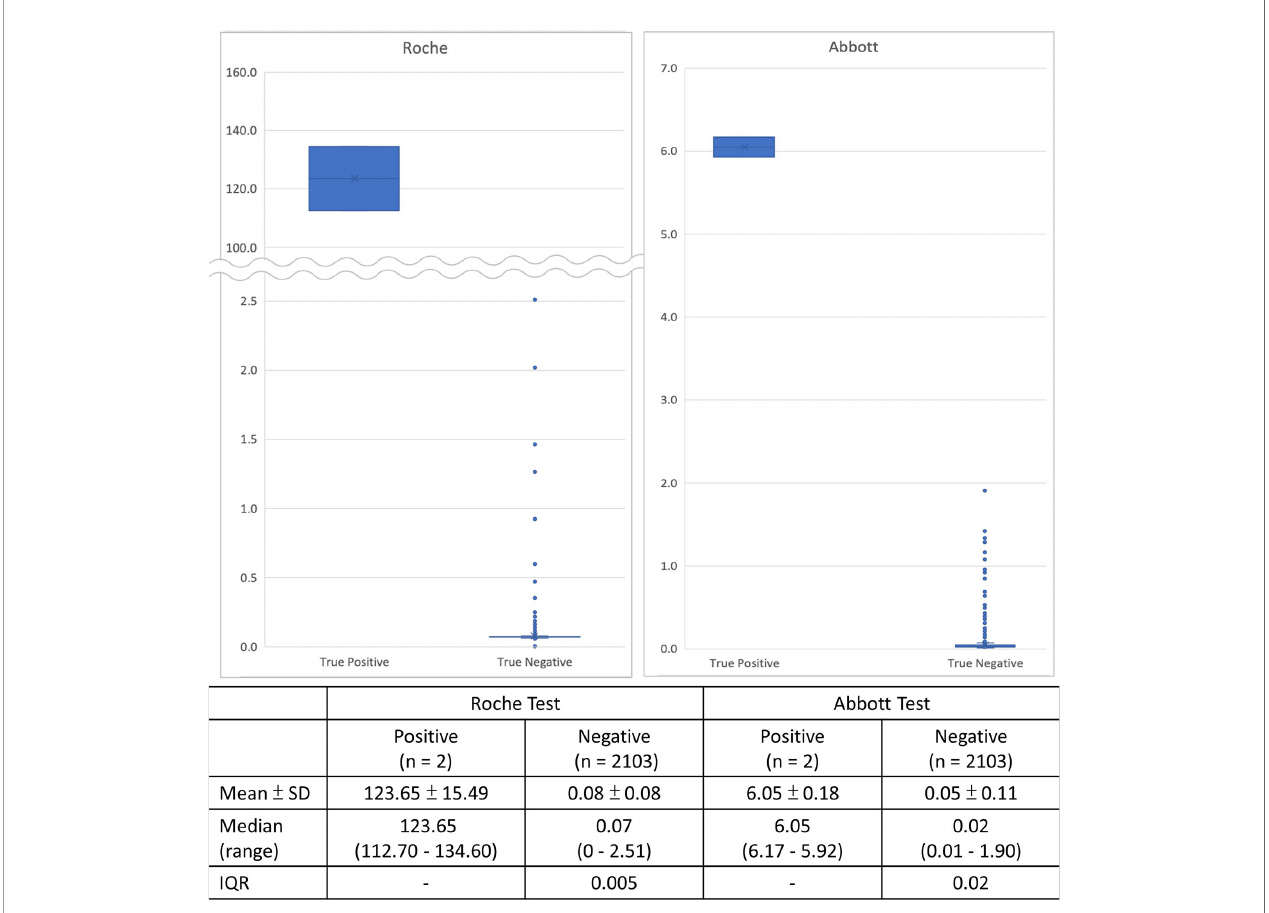
FIGURE 4 | Distribution of serological test results of the 2,105 seroprevalence study participants of the two automated chemiluminescent immunoassays, strati fi ed by fi nal positive and negative interpretation from combining the results of the recom Line SARS-CoV-2 IgG line immunoassay and the three lateral fl ow